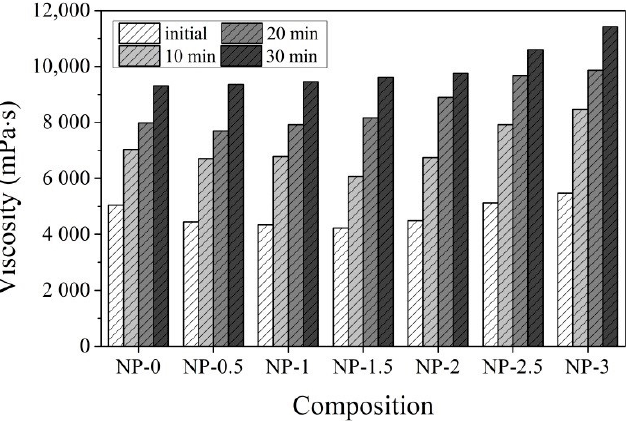
Figure 2. Viscosity of CEM IIN paste (LN) with different dosages of CN (0–3%) depending on time at +20 °C temperature (0—immediately after paste preparation; 10—after 10 min; 20—after 20 min; 30—after 30 min).